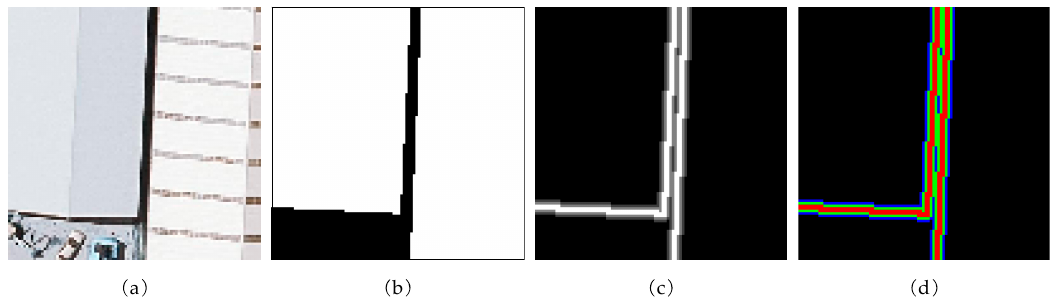
Figure 5. ( a ) is a cropped bin from the VHR image, ( b ) is the building mask map, ( c ) is the boundary mask and ( d ) is the generated bonus map where pixels of red, green, blue and black colors represent the values of 1, 0.5, 0.25 and 0, respectively.